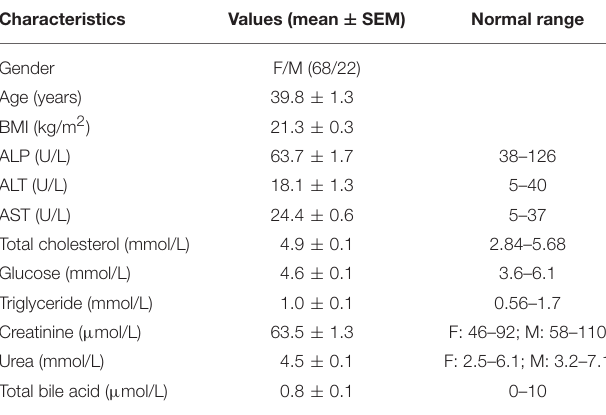
TABLE 2 | Demographics and clinical characteristics of healthy human